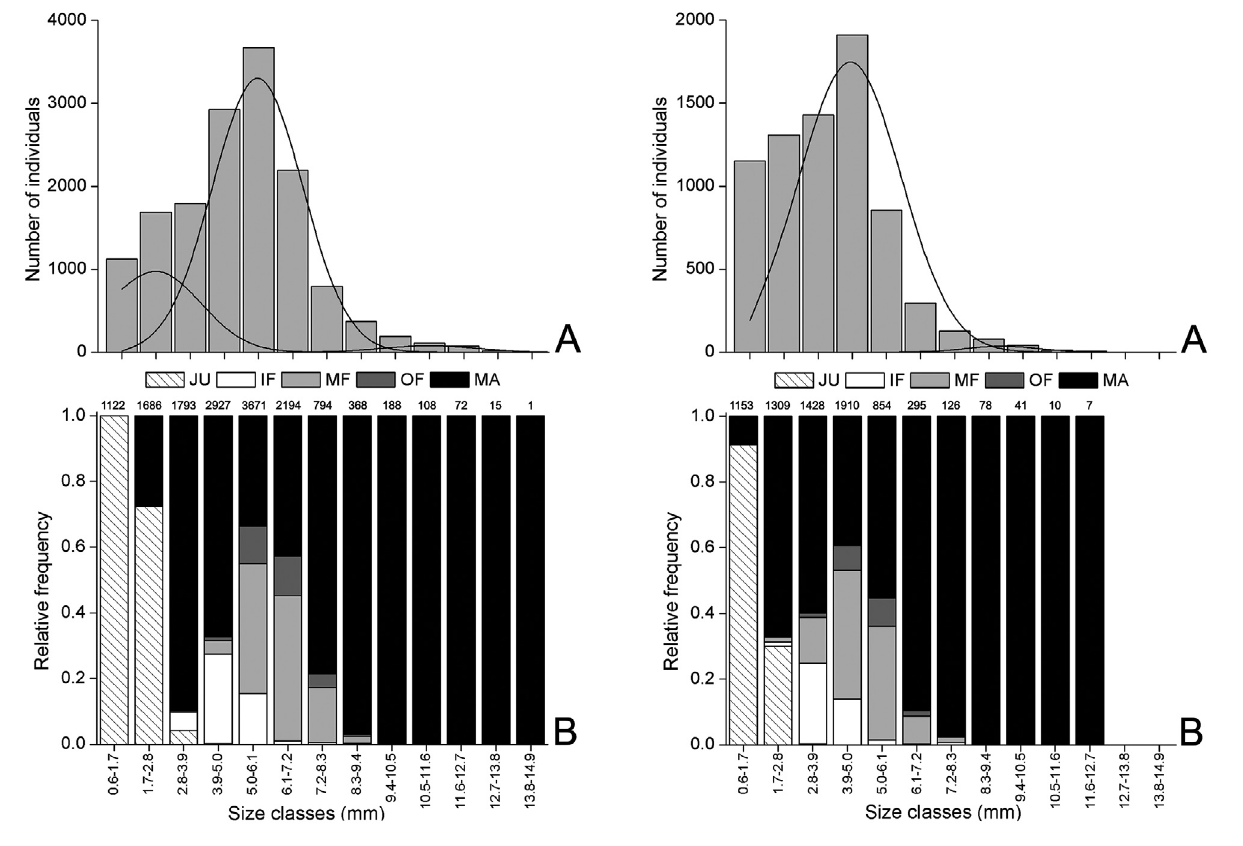
Fig. 2. – Population distribution of Caprella danilevskii in the Ubatuba Fig. 3. – Population distribution of Caprella equilibra in the Ubatuba region, southeastern Brazil. A, observed population distribution of region, southeastern Brazil. A, observed population distribution of the individuals collected in this study; B, relative frequency of the the individuals collected in this study; B, relative frequency of the individuals by size classes (mm) and demographic categories. JU, individuals by size classes (mm) and demographic categories. JU, juveniles; IF, immature females; MF, mature females; OF, ovigerous juveniles; IF, immature females; MF, mature females; OF, ovigerous females; MA, males. females; MA,